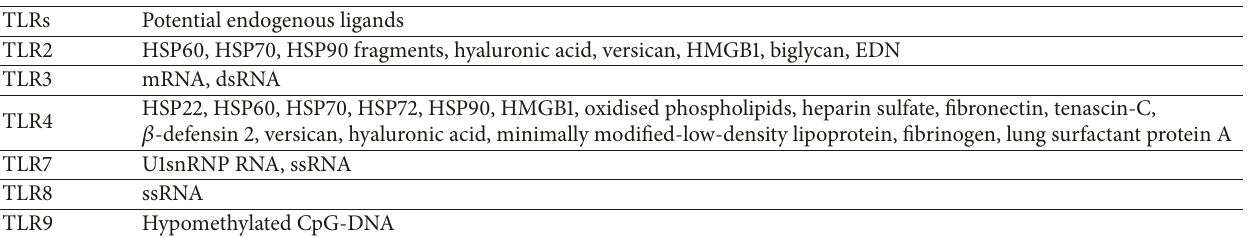
Table 1: TLRs involved in autoimmune disease with the ligands causing the immune reaction. (EDN: eosinophil-derived neurotoxin; Hsp: heat shock protein; HMGB1: high-mobility group box 1